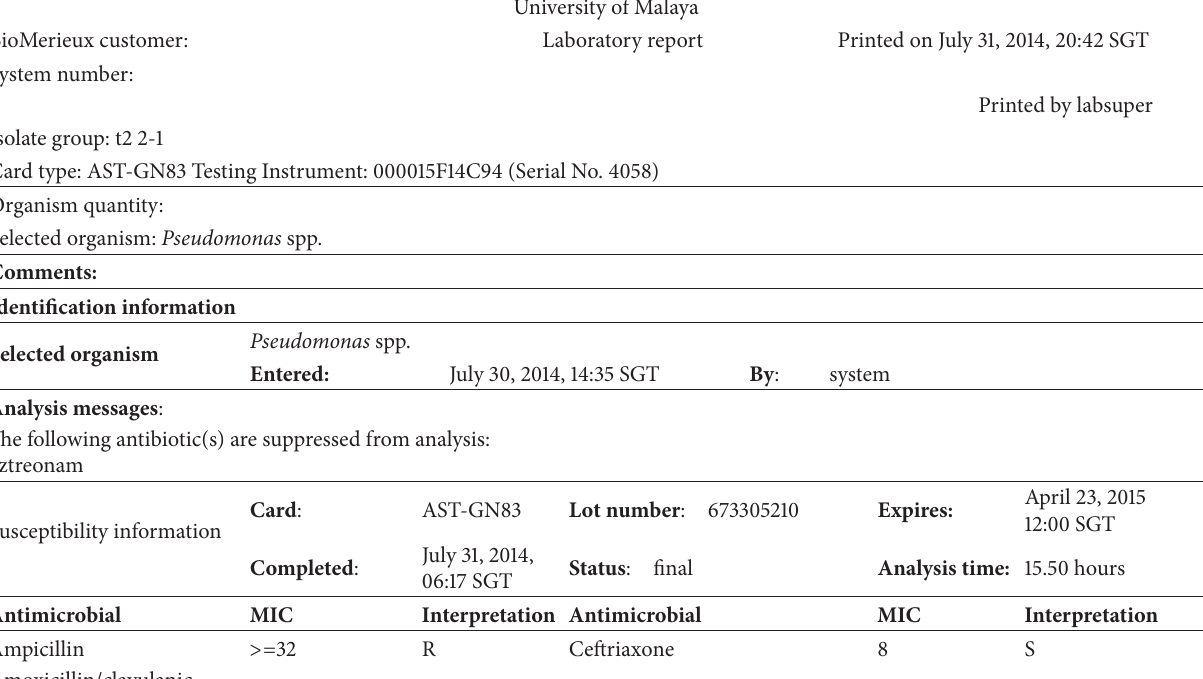
Table 3: Antibiogram of Pseudomonas putida strain T2-2. Antimicrobial compounds with MICs higher than expected were regarded as resistant by strain T2-2 and marked as “R” while the compounds with lower or equal to expected MICs were interpreted as sensitive for strain T2-2 and were marked as